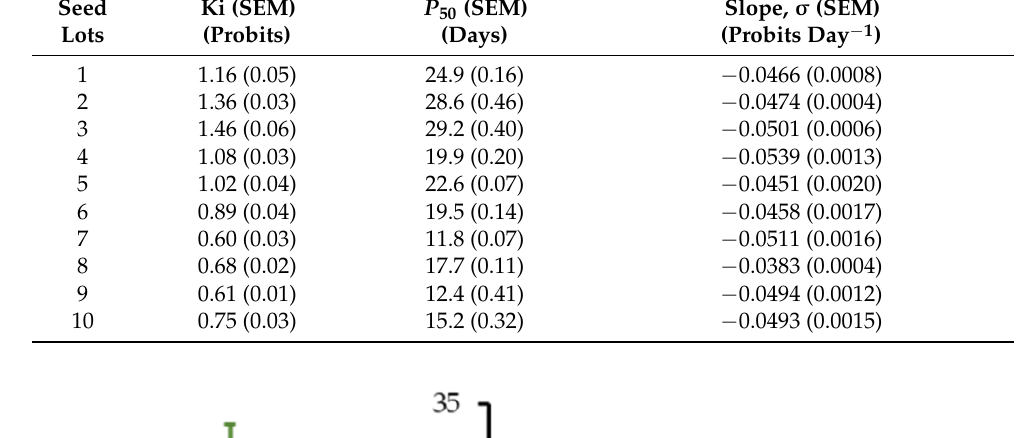
Ki values varied between 0.60 and 1.46 as probit values. Mean P 50 values ranged be- tween 11.8 and 29.2 days. The highest Ki and longest P 50 value were seen in the seed on Lot 3. Lot 7 showed the lowest Ki value and the shortest P 50 value as days. RE 80 h counts (Table 1) and Ki and P 50 (Table 2) were regressed and highly related ( Ki p < 0.001, R 2 = 0.888, P 50 p < 0.001, R 2 = 0.823) (Figure 3).